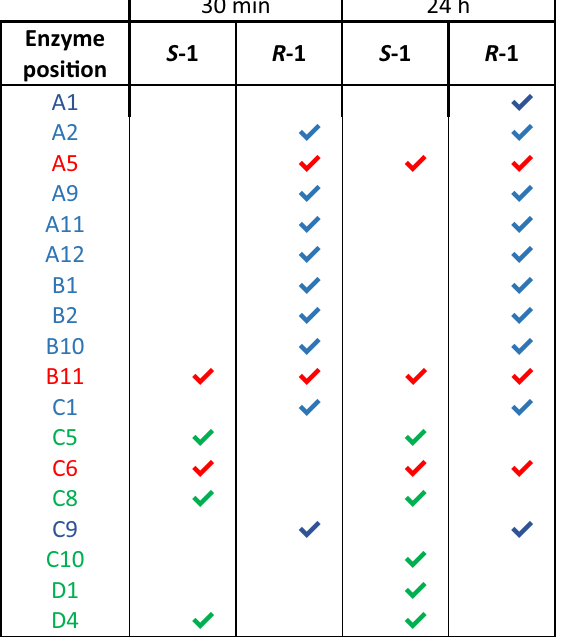
Table 2. Stereopreference evaluation of NADP + -dependent KREDs. Summary of NADP + -dependent enzymes active on (R) - 1 in blue, (S) - 1 in green and both the enantiomers in red.